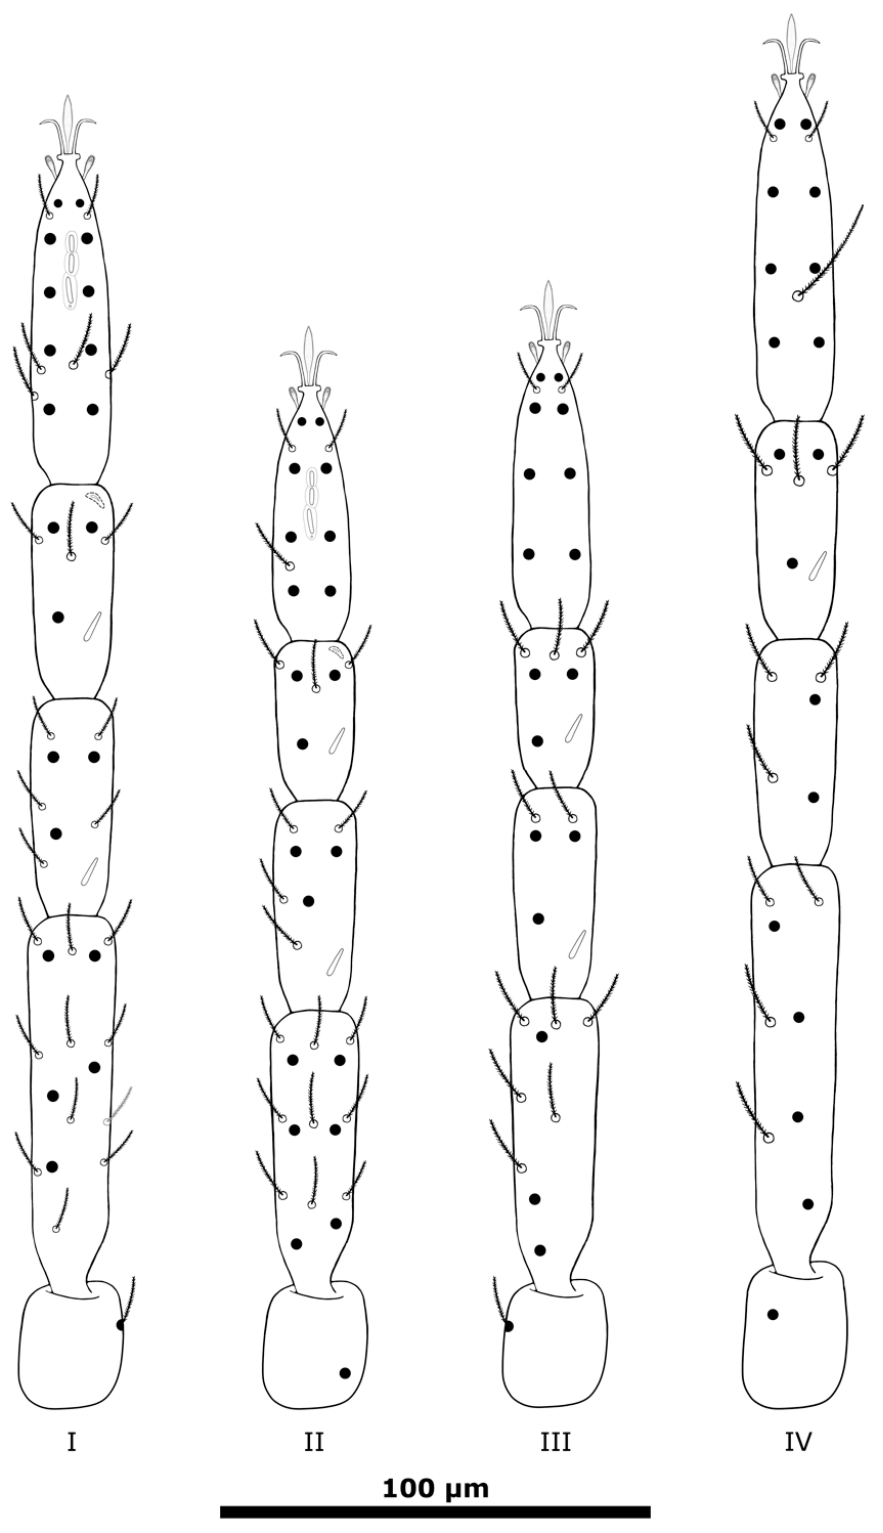
Figure 4. S. ineffabilis sp. nov. Chaetotaxy of legs of Prior Island specimens; black dots represent the setae on the ventral side; light grey indicates setae that are sometimes missing; rhagidial organs visible on tarsi I and II and subtended by small nude round setae; outlines after the drawings of Pittard [2] arranged with proportions and details of S. ineffabilis .